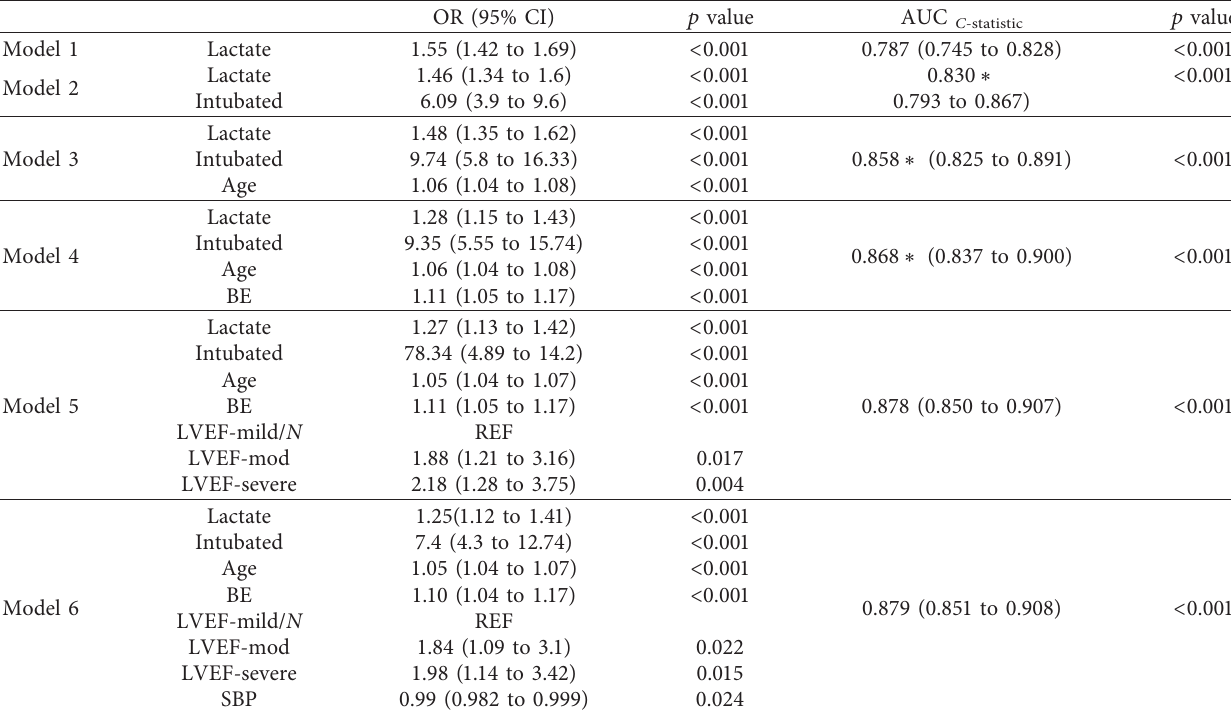
Table 3: Forward conditional logistic regression analysis determining main independent “frontline” predictors of 30-day